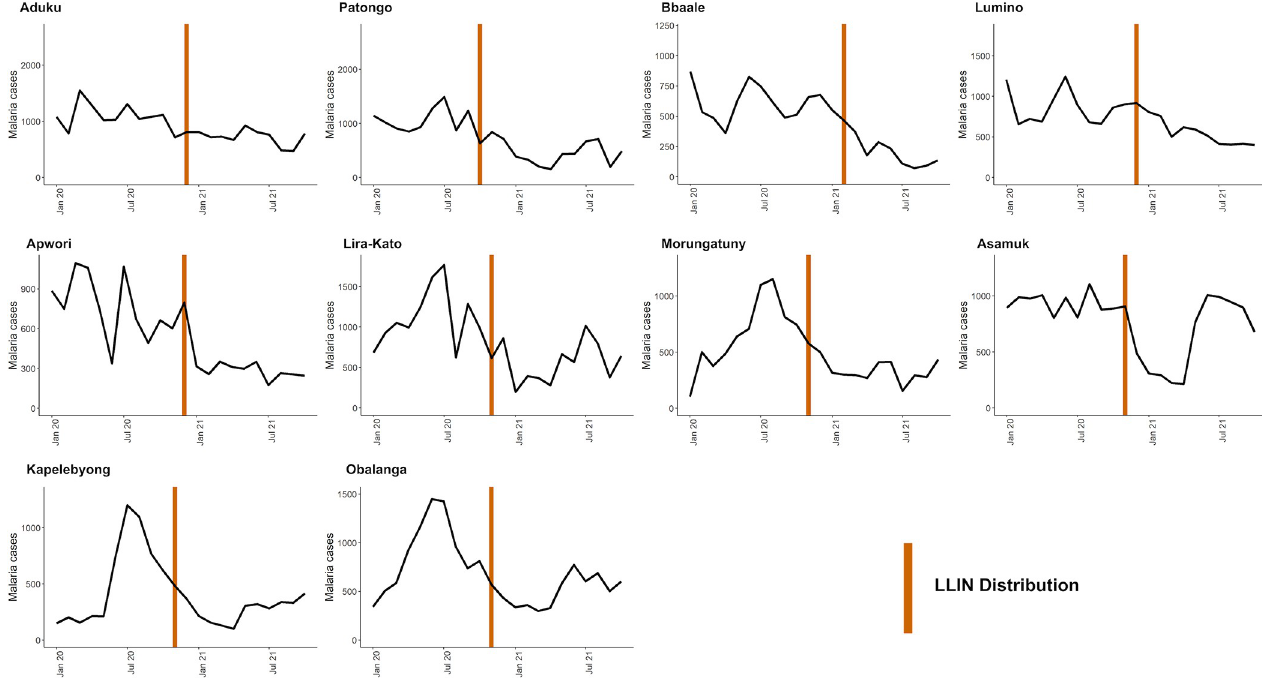
Fig 4. Malaria case counts and vector control interventions over time at 10 sites that have not received IRS recently.